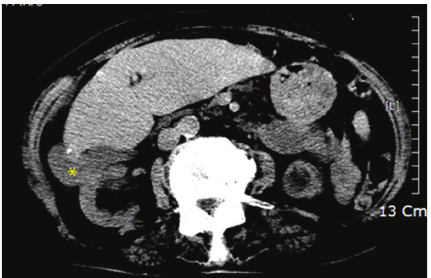
Figure 4: Axial plane of the abdominal CT examination revealed the ectopic position of the gallbladder (asterisk) which was laterally